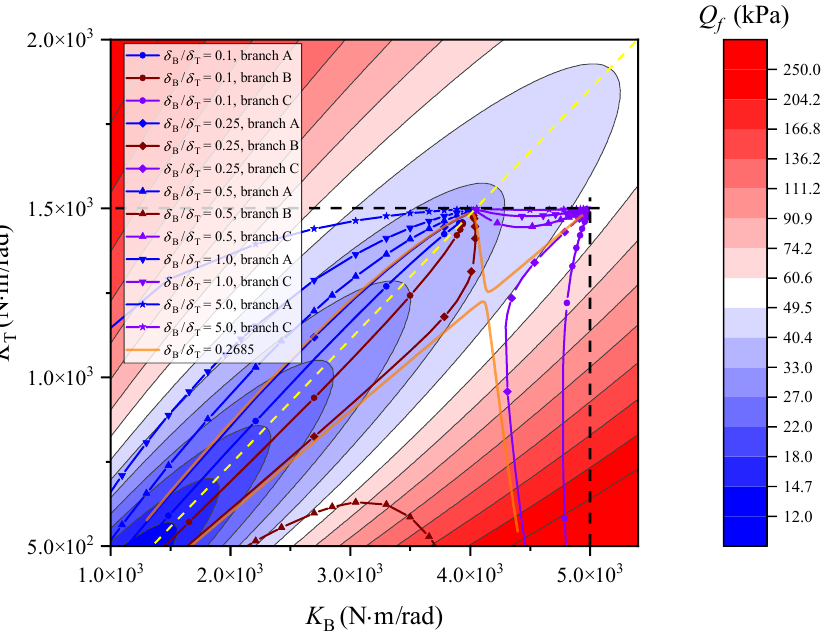
Figure 20. LCO solutions on linear flutter dynamic pressure nephogram ( K B = 5.0 × 10 3 N · m/rad, K T = 1.5 × 10 3 N ·